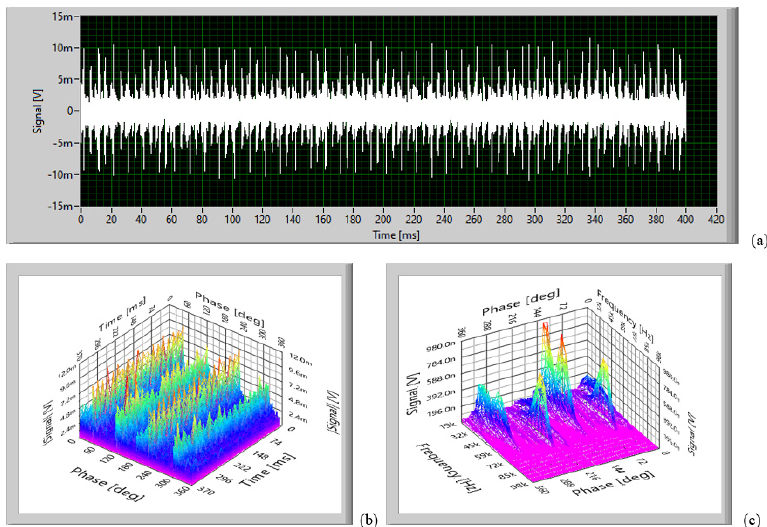
Figure 7. Acoustic image of the selected AE signal from area AE-2 within the map from Figure 4c (after filtration of AE signal within the 20–100 kHz band): ( a ) transient signal; ( b ) phase–time characteristic; ( c ) averaged STFT spectrogram. AE signal parameters: ADC = -351, U pp = 27.47 mV, U rms = 1.59 mV.